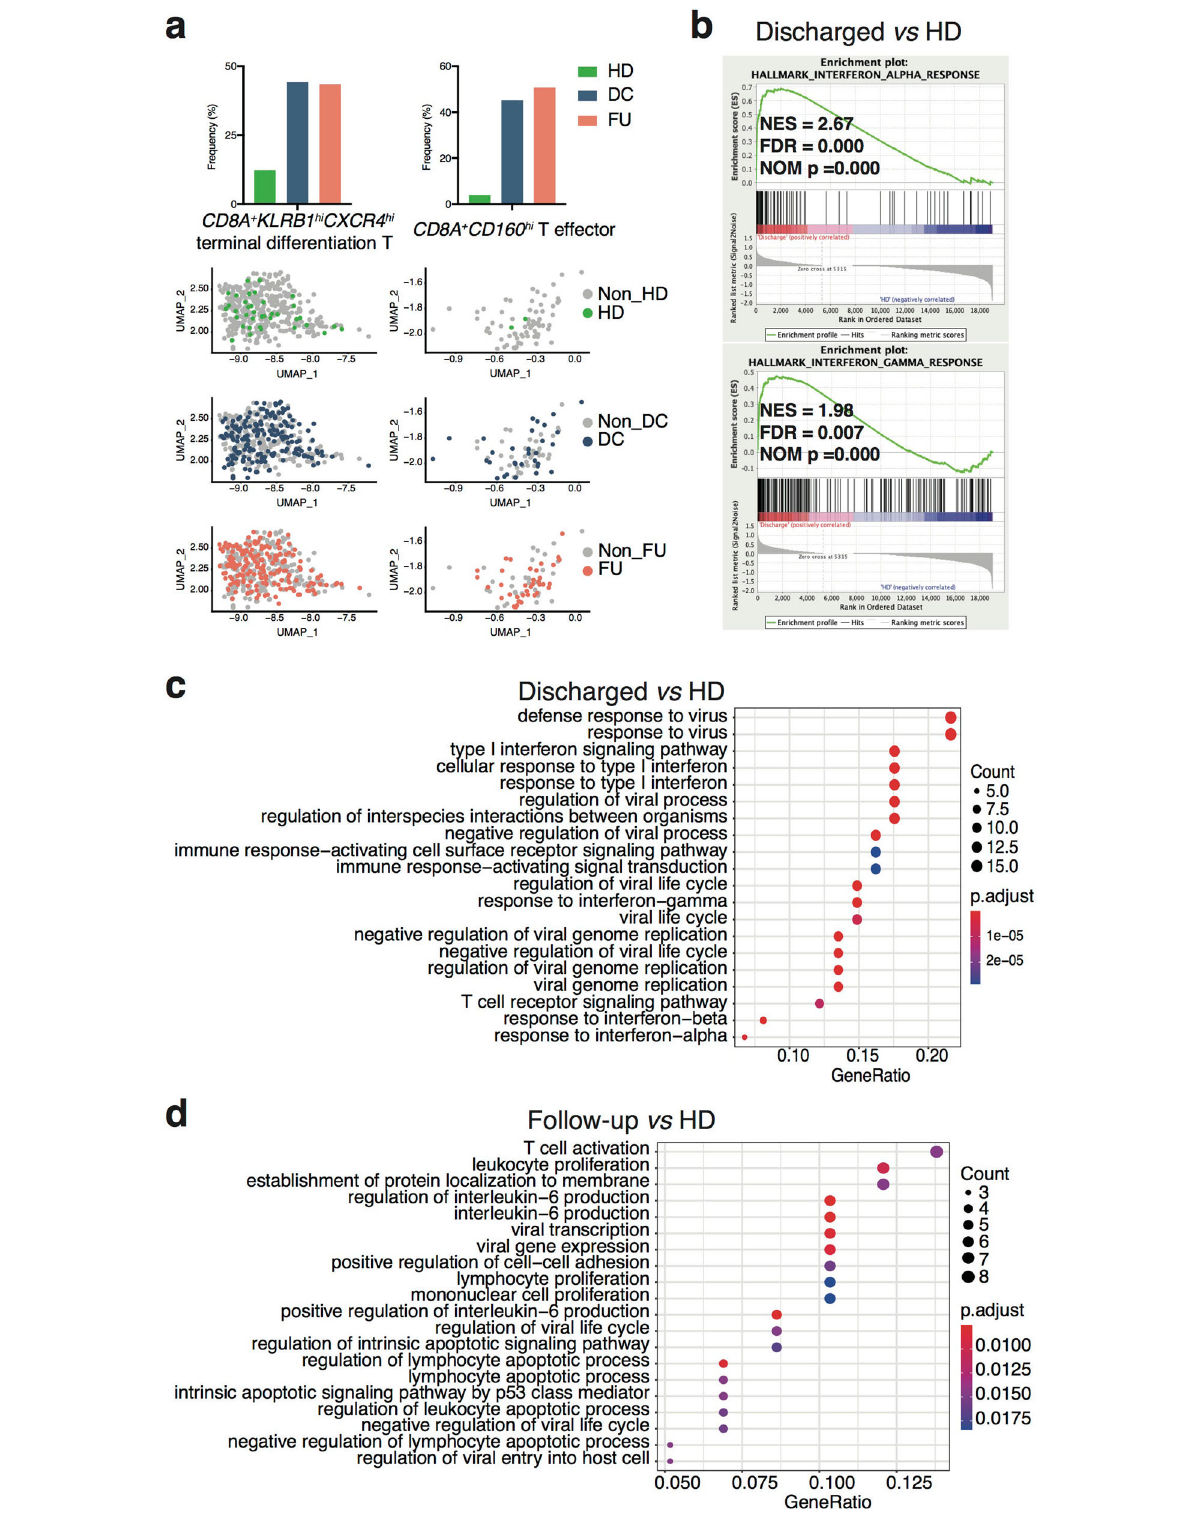
Fig. 5 (See legend on next